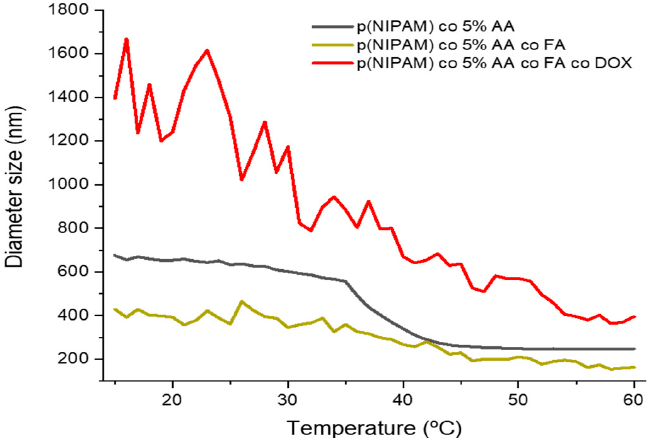
Figure 2. Size change of p(NIPAM)-based microgels against heating cycle temperature. The PDI for p(NIPAM)-co-5%AA, p(NIPAM)-co-5%AA-co-FA, and p(NIPAM)-co-5%AA-co-FA-co-Dox is 0.107, 0.482, and 0.531, respectively.